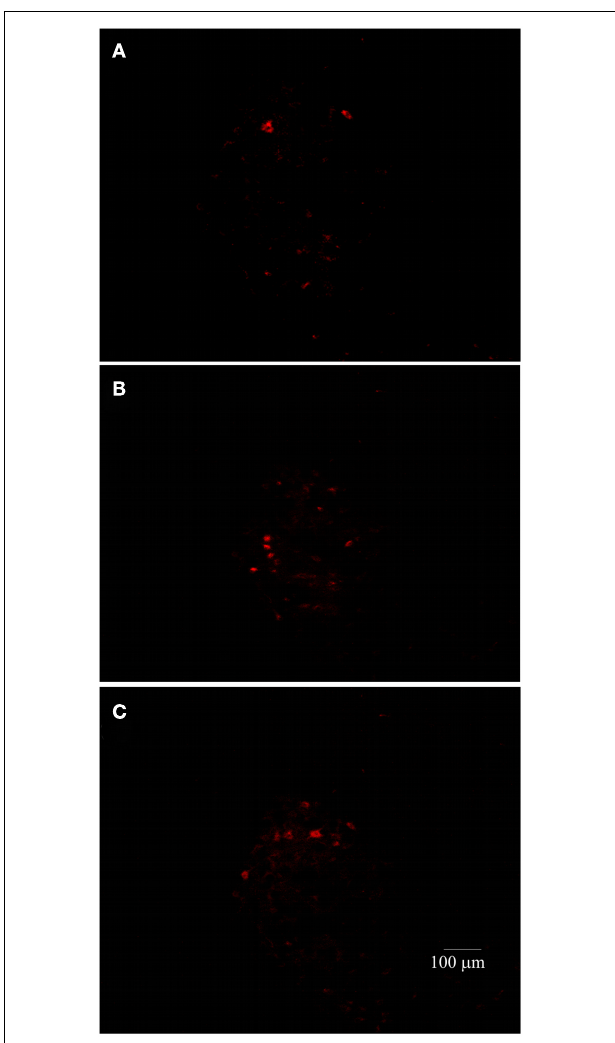
FIGURE 5 | Representative photomicrographs of the red nucleus of SC-injured Lewis (A), Fischer 344 (B), or Sprague–Dawley (C) rats . The number of RSNs was lower in Lewis